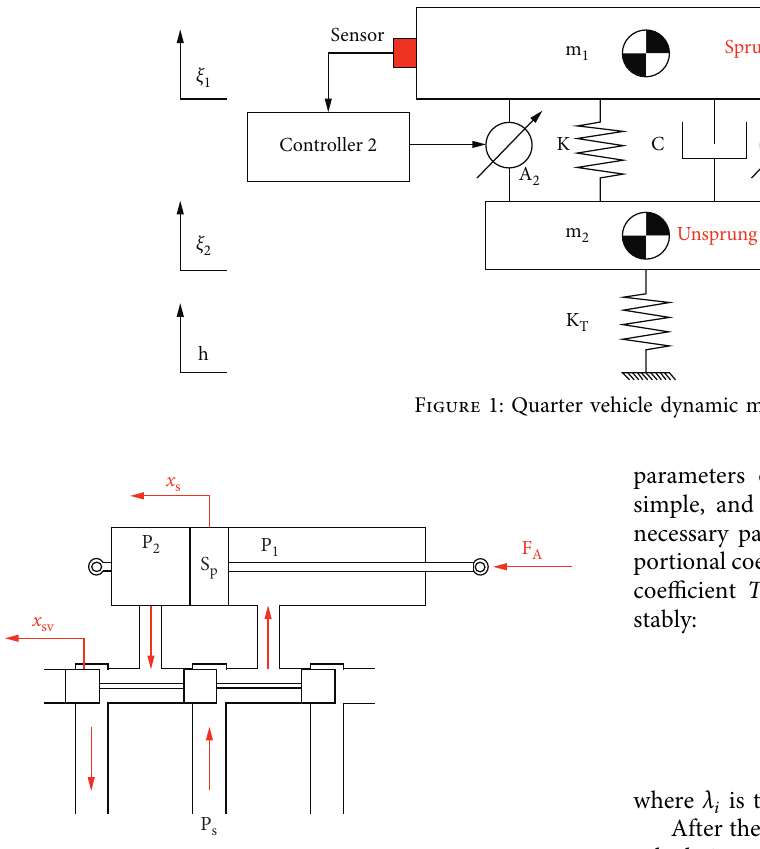
Figure 2: Hydraulic actuator of the active suspension